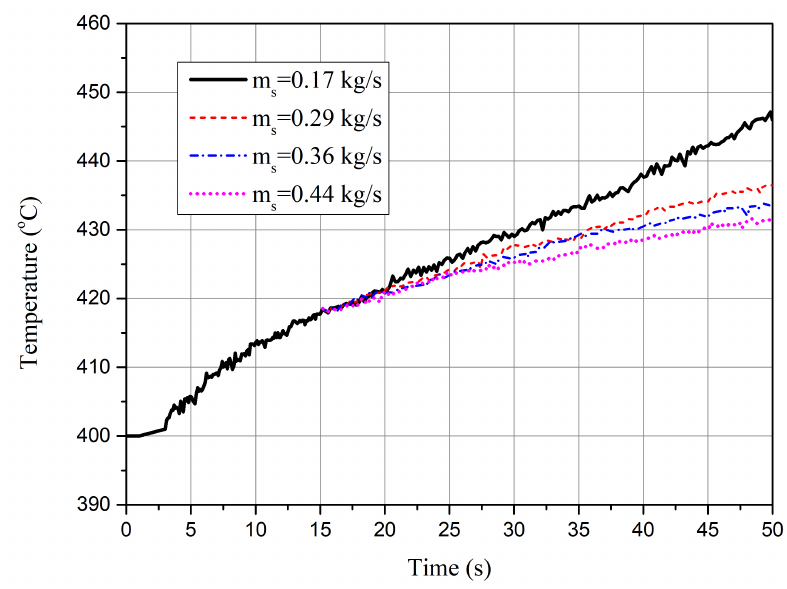
Figure 16. Profile of time-averaged gas and solid vertical velocity.